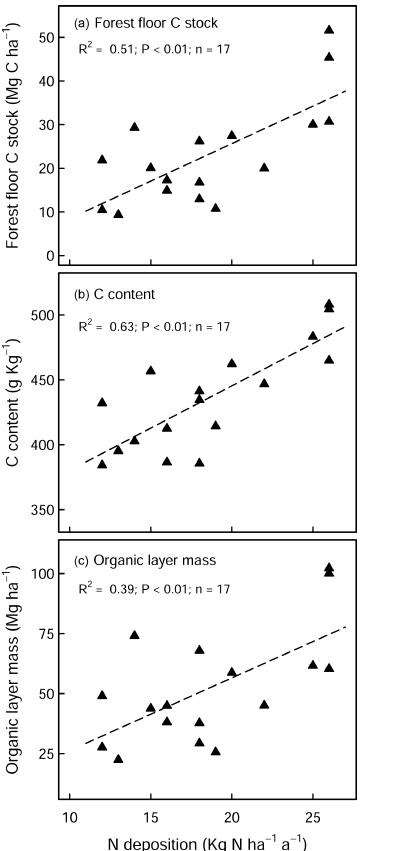
Figure A1. Location of the 28 paired liming experiment sites in Germany where soil organic carbon samples were collected.